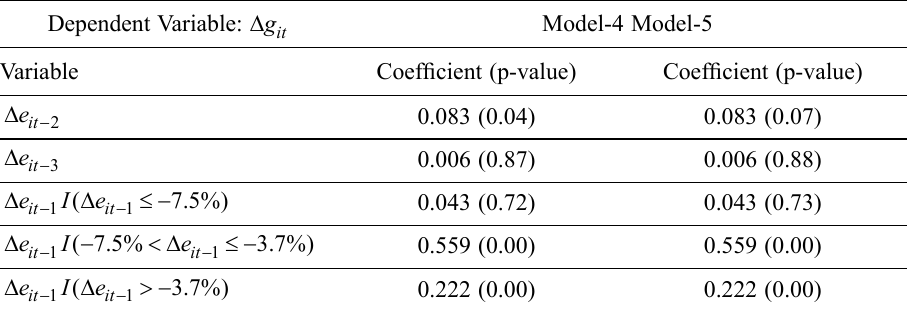
Table 5. Estimation result of the static panel threshold